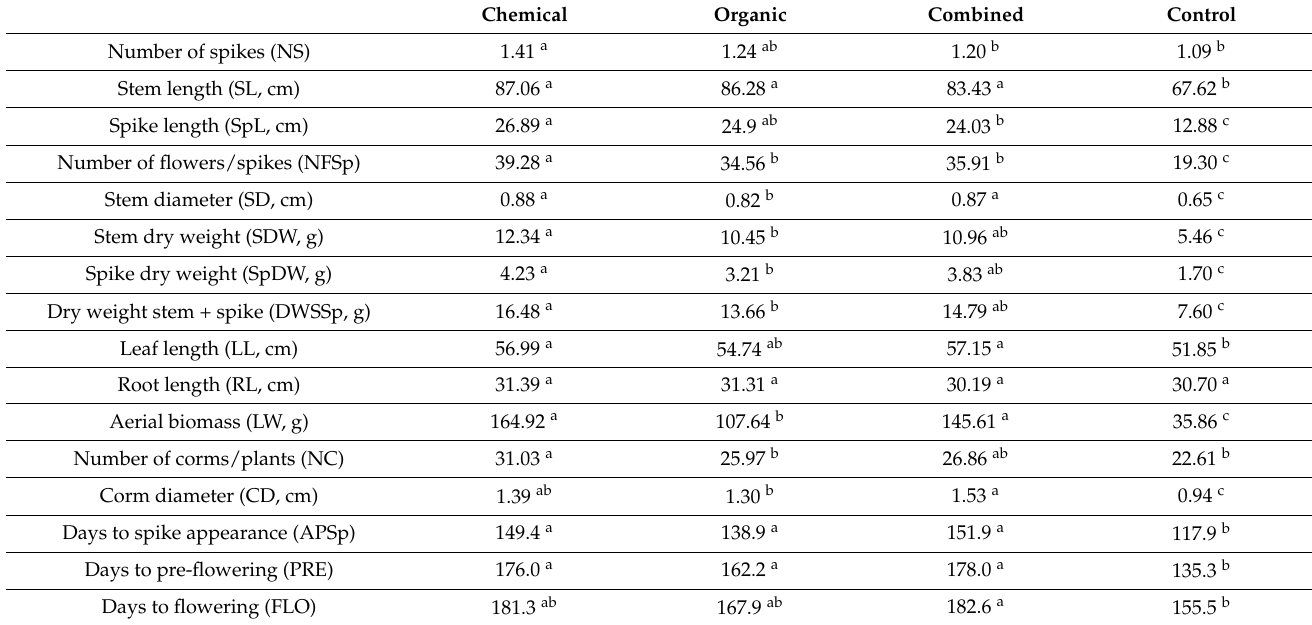
Table 11. Tuberose spike, stem, and leaf characteristics and days to appearance of the spike, to pre-flowering, and to flowering with different sources of fertilization.